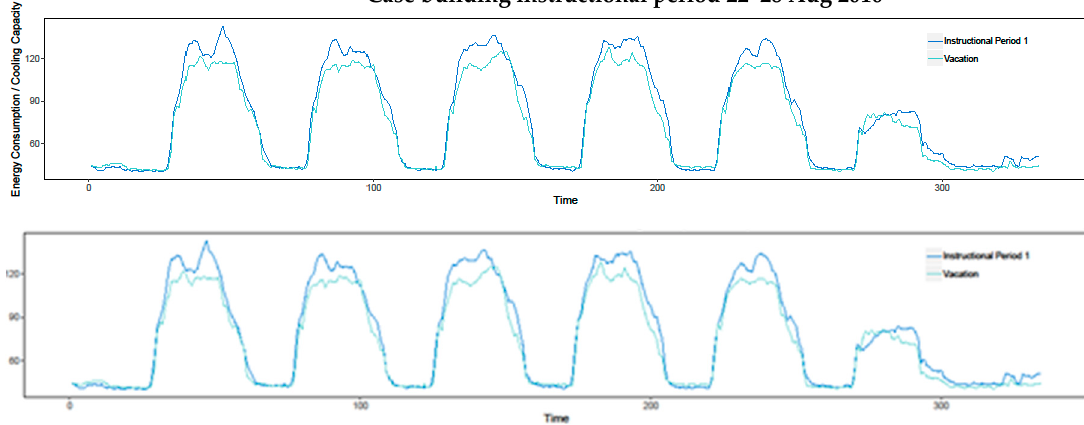
Figure 3. Trend in the data.